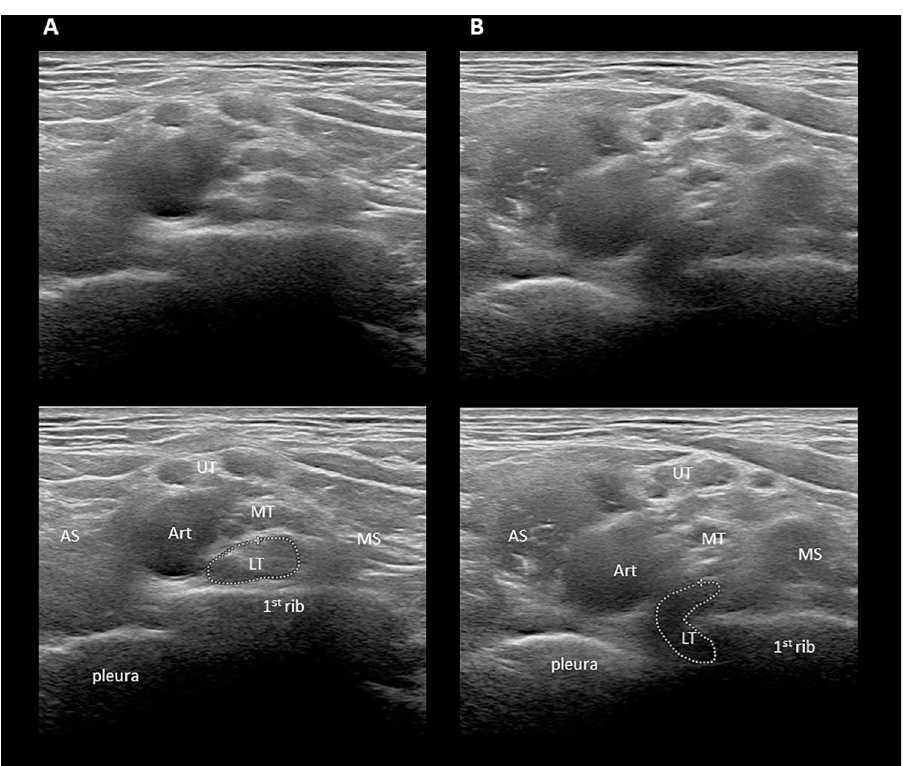
Fig 2. The bony ‘wedge-sickle sign’. Axial images showing the right brachial plexus in the supraclavicular fossa in patient with neurogenic (supra- + costoclavicular) TOS. Image B is cephalad relative to image A . In A , note the elevated position of the 1 st rib. In B , note that the medial edge of the 1 st rib indents the lower trunk from the lateral direction, which assumes a sickle shape and is moderately hypoechoic and swollen. LT: lower trunk; MD: middle trunk; UP: upper trunk; MS: middle scalene muscle; AS: anterior scalene muscle; Art: subclavian artery.